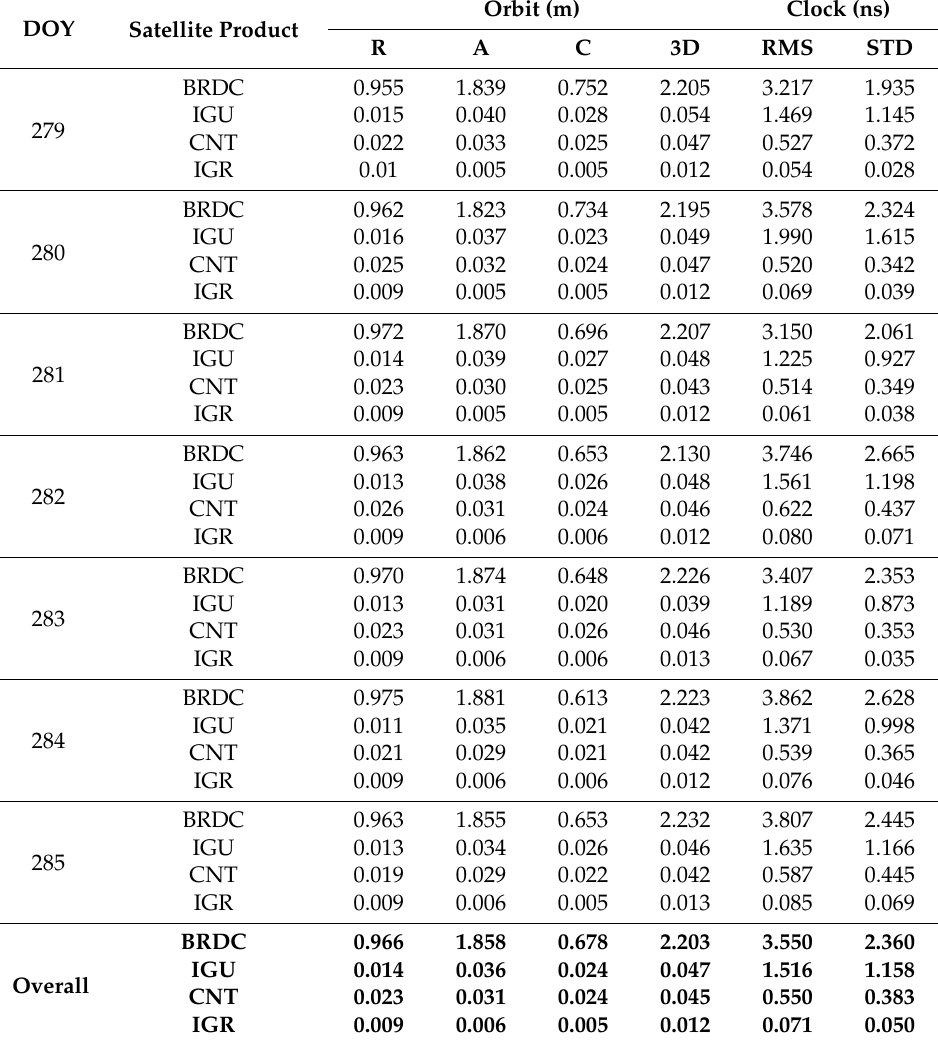
Table 1. Satellite orbit and clock accuracies over the period from DOY 2013 279 to